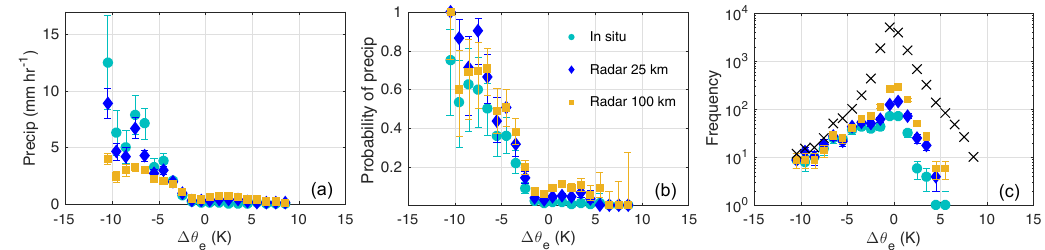
Figure 7. (a) Precipitation (1h averages) conditionally averaged by coincident changes in equivalent potential temperature ( (cid:49)θ e ) at the GoAmazon site. Precipitation values corresponds to the θ e values at the end of each differencing interval. Bins are a width of 1 ◦ and error bars represent the standard error. (b) The probability of precipitation (>2mmh − 1 ) occurring for a given (cid:49)θ e . Error bars represent Wilson score intervals from 5 to 95%. (c) The frequency of occurrence of (cid:49)θ e and precipitation for a given (cid:49)θ e (precipitation >2mmh − 1 ) . Precipitation derived from S -band radar reflectivity at spatial averages over 25 and 100km grid boxes surrounding the GoAmazon site is included for comparison to the in situ